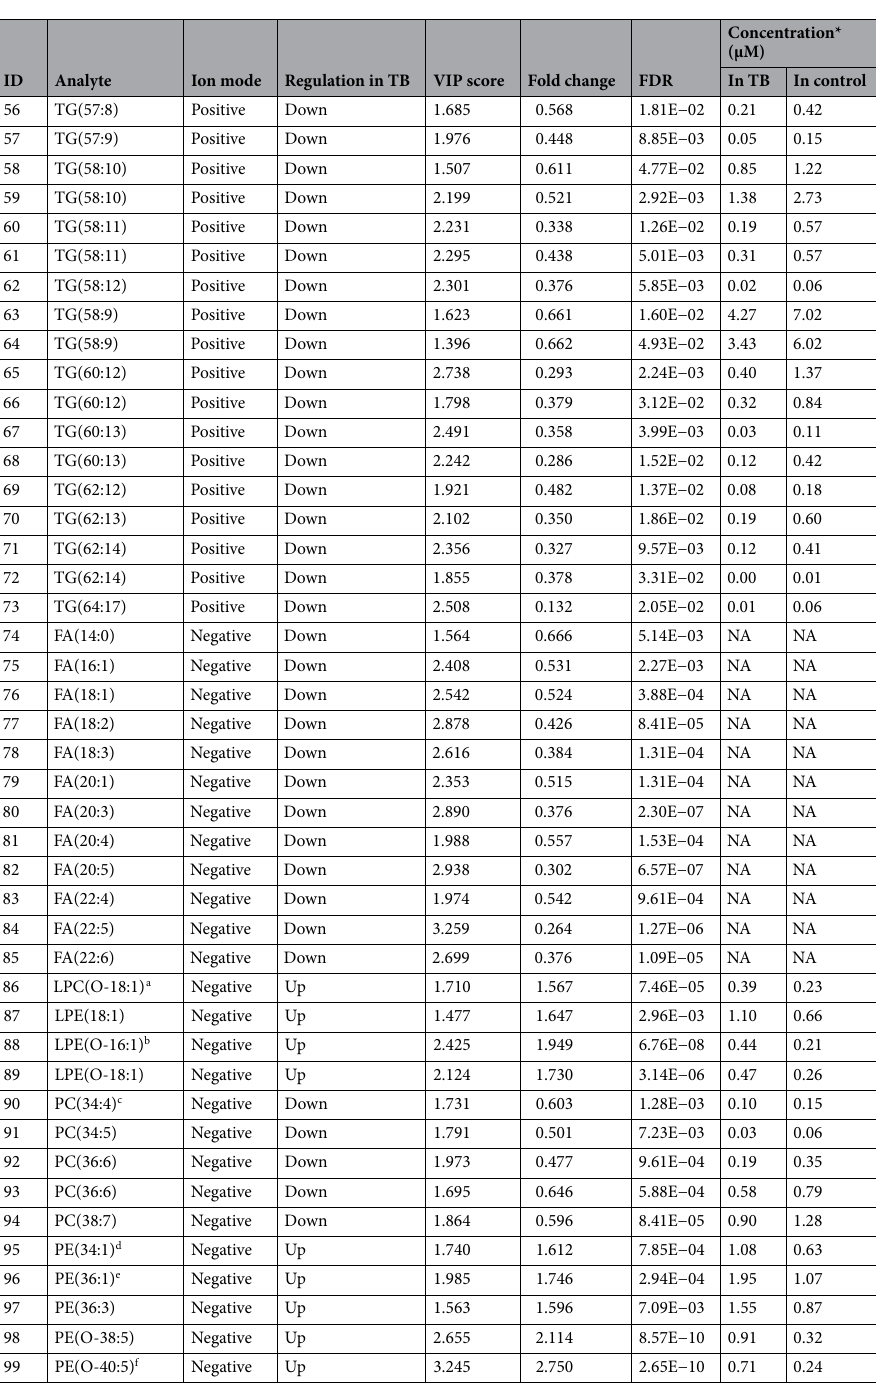
Table 1. Statistics information of the potential biomarkers for TB versus control distinguish. TB tuberculosis, VIP variable importance in projection, FDR false discovery rate, NA no information, CAR acylcarnitine, Cer ceramide, Hex2Cer hexosylceramide, LPC lysophosphatidylcholines, LPC (O-) Ether- linked lysophosphatidylcholines, PC phosphatidylcholine, PC (O-) Ether-linked phosphatidylcholine, LPE lysophosphatidylethanolamines, LPE (O-) Ether-linked lysophosphatidylethanolamines, PE phosphatidylethanolamine, PE (O-) Ether-linked phosphatidylethanolamine, PI phosphatidylinositol, NAE N-acetyl ethanolamine, DG diacylglycerol, TG triacylglycerol, FA free fatty acid. a– f Analyte detected in both positive and negative mode. *Single point quantification by using the peak area ratios with matched lipid class of available internal